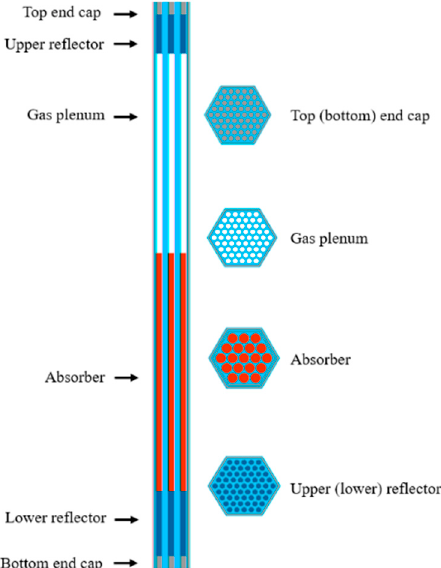
Figure 3. Control assembly configuration.